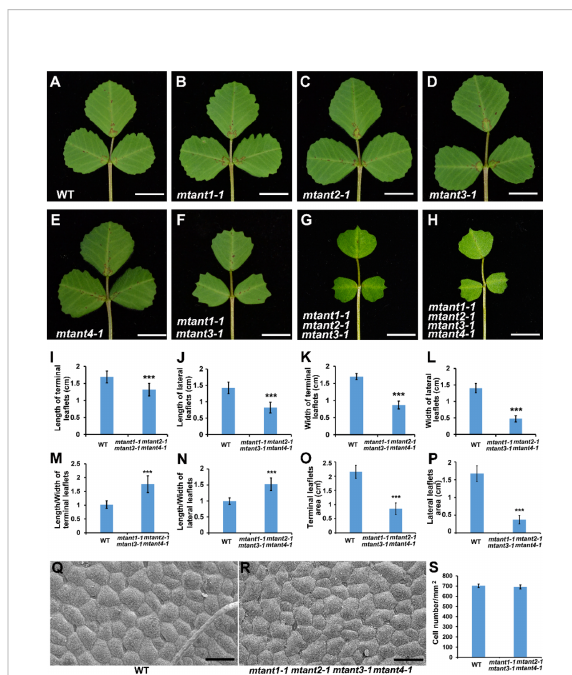
FIGURE 6 Phenotype analyses of leaves in mtant mutants. (A – H) Leaf phenotypes of wild type (A) , mtant1-1 (B) , mtant2-1 (C) , mtant3- 1 (D) , mtant4-1 (E) , mtant1-1 mtant3-1 (F) , mtant1-1 mtant2-1 mtant3-1 (G) and mtant1-1 mtant2-1 mtant3-1 mtant4-1 (H) . Bars = 1 cm. (I – L) Leaf length (I – J) and width (K, L) in terminal lea fl ets and lateral lea fl ets of wild type and mtant1-1 mtant2-1 mtant3-1 mtant4-1. (M – P) Length/width ratio (M, N) and leaf area (O, P) of terminal lea fl ets and lateral lea fl ets in wild type and mtant1-1 mtant2-1 mtant3-1 mtant4-1. (Q, R) Scanning electron microscopy analyses of the adaxial surface of leaves in wild type (Q) and mtant1-1 mtant2-1 mtant3-1 mtant4-1 mutant (R) . Bars = 50 m m. (S) Cell number per unit area of the adaxial surface of leaves in the wild type and mtant1-1 mtant2-1 mtant3-1 mtant4- 1 mutant. Bars represent means ± SD. ***P <